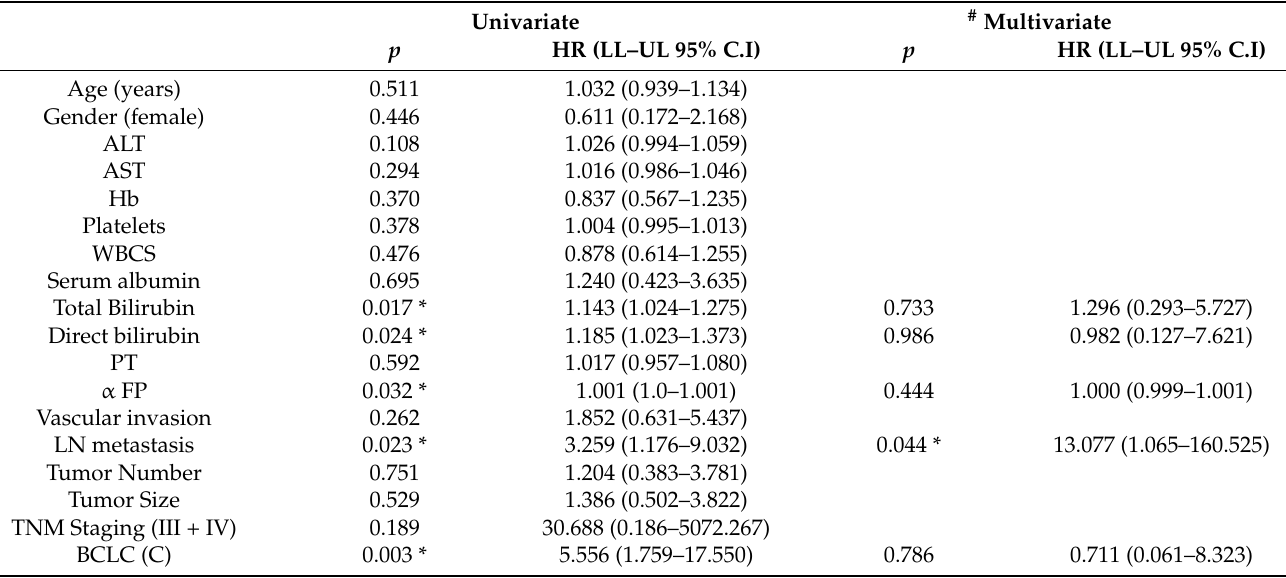
Table 6. Univariate and multivariate COX regression analysis for the parameters affecting mortality.